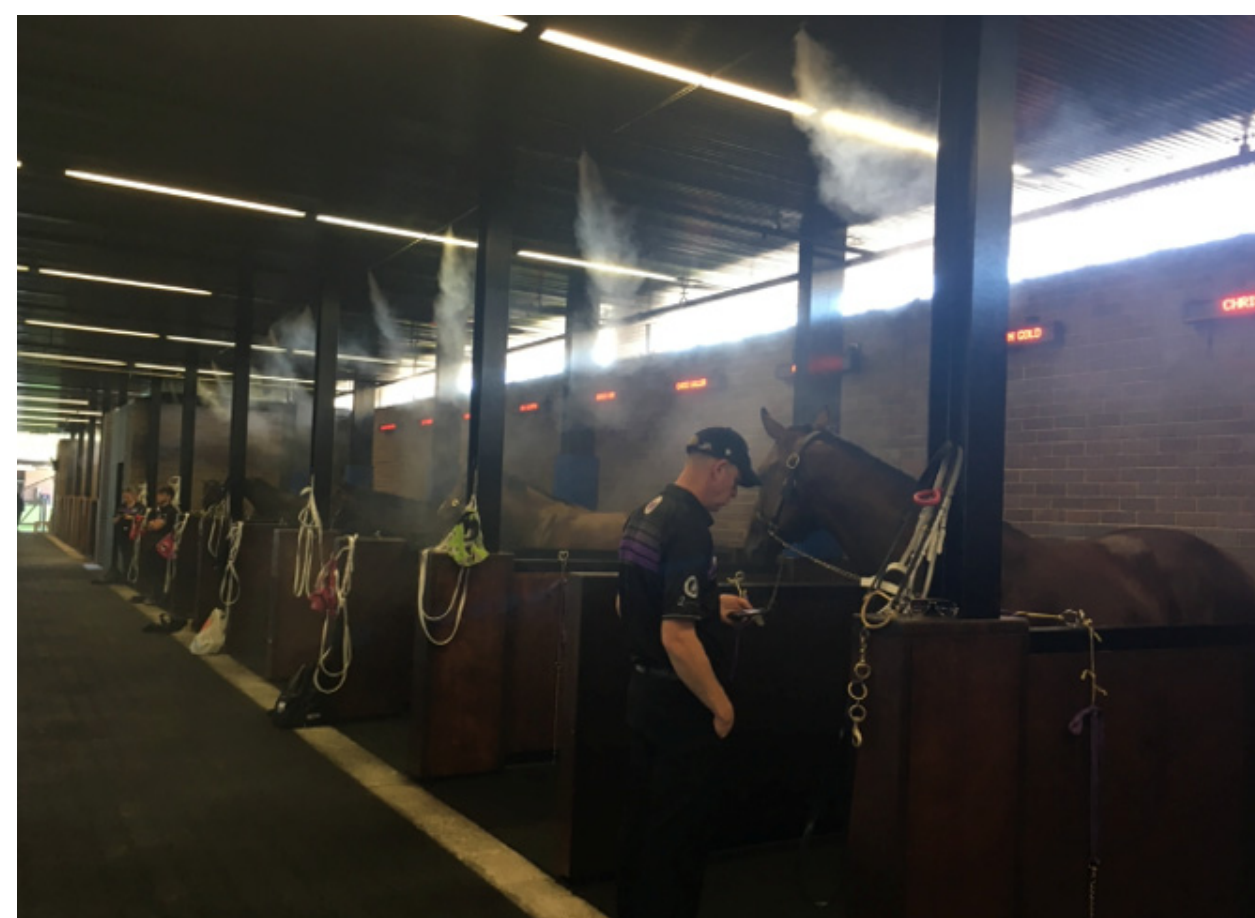
Figure 27. Misting sprays in the tie-up stalls at a racecourse in Australia. The devices can theoretically increase the humidity by up to 20% in the immediate vicinity, negatively affecting thermoregulatory capacity.